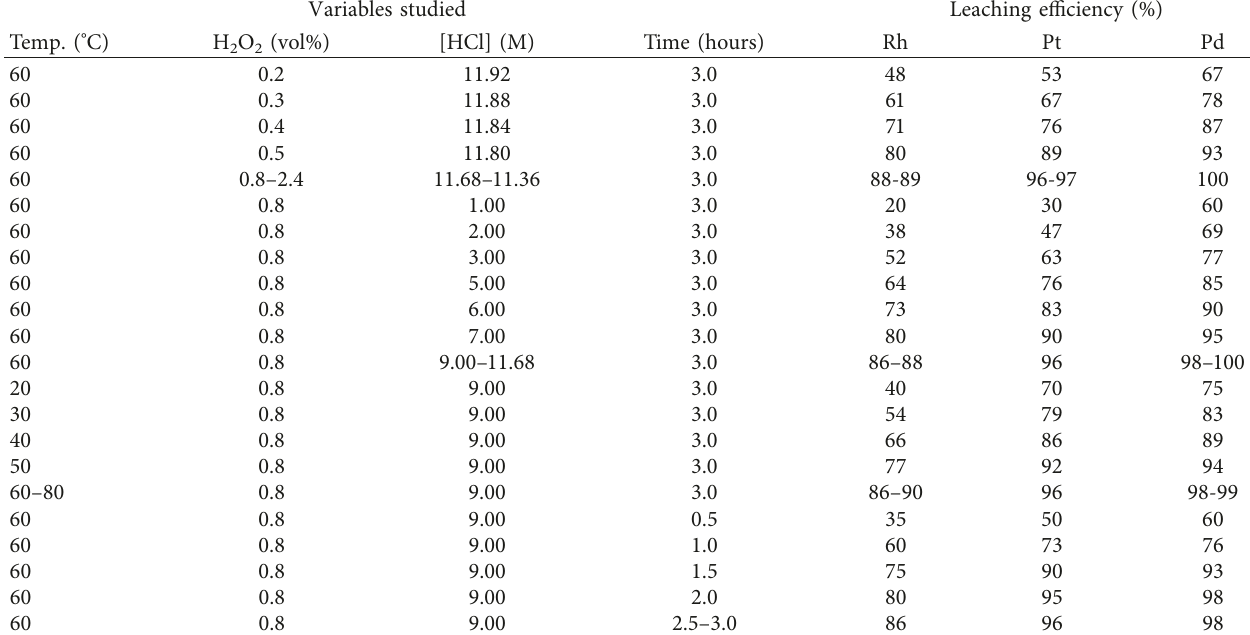
Table 2: Effect of the various variables examined during leaching process on the PGM leaching efficiencies. Variables